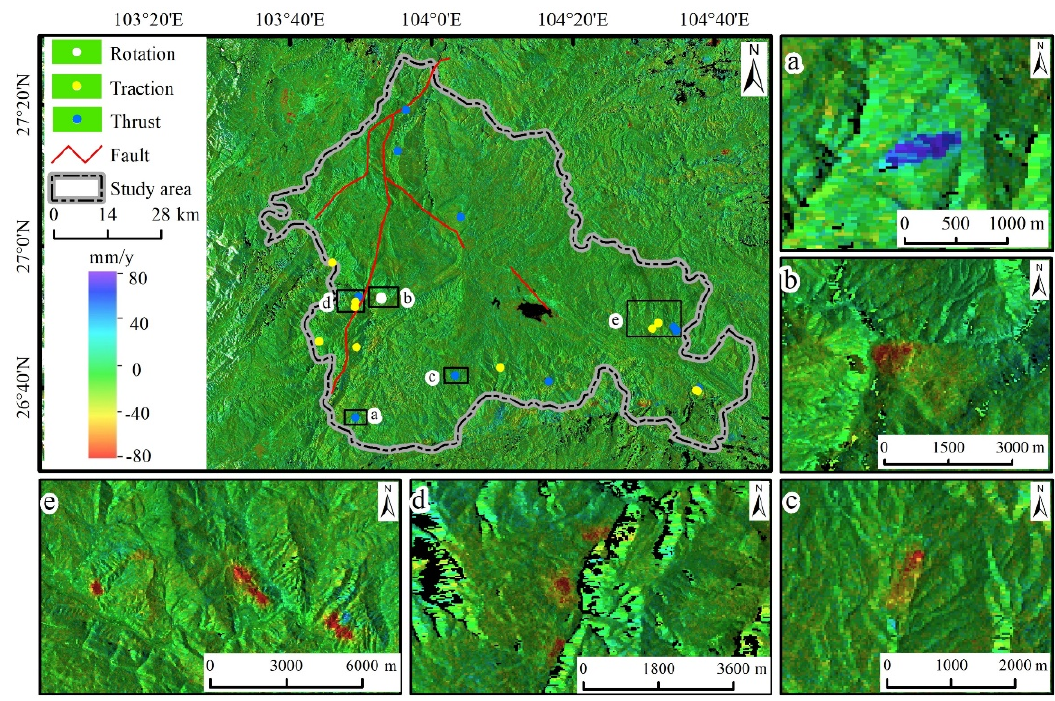
Figure 7. Active landslide distribution in Weining. The solid circles are the locations of active landslides, and the base diagram is the average annual displacement rate obtained by the descending images. ( a − e ) show the partial enlargements. (In order to better show the landslide boundaries, only the displacement between − 80 mm/y to 80 mm/y is shown, and it should be emphasized that there are still very few areas with displacement velocities over ±150 mm/y).